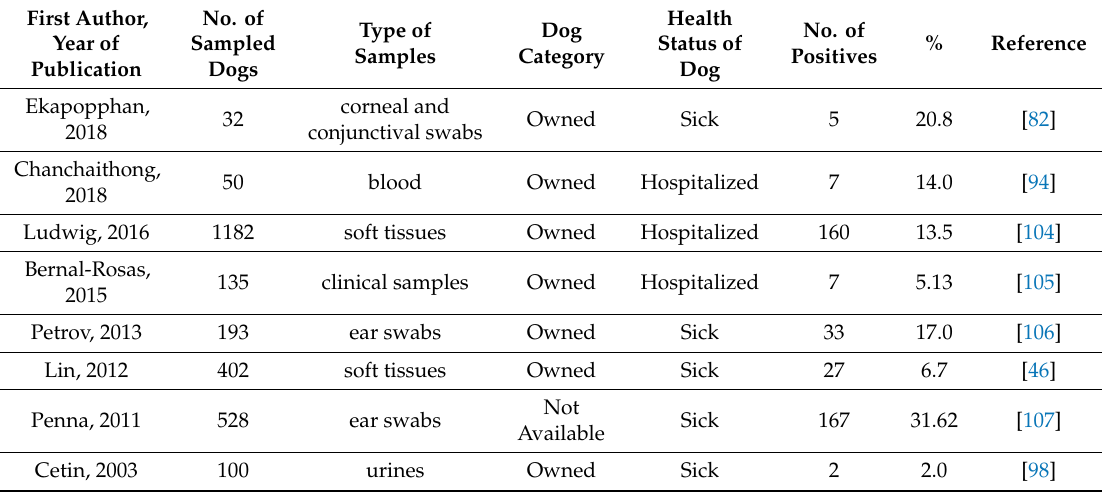
Table 6. Data of the included articles regarding the presence of Pseudomonas aeruginosa in dogs.